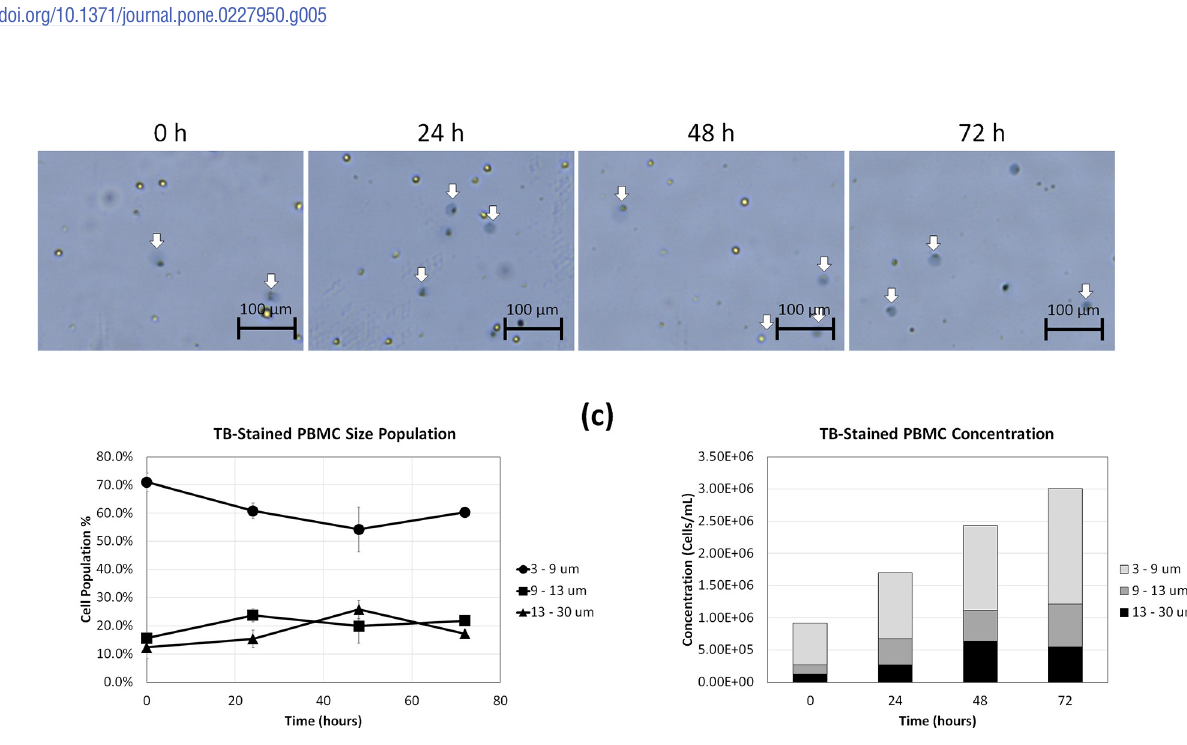
Fig 6. Time-course morphological analysis of TB-stained PBMCs. (a) Bright field images of TB-stained PBMCs acquired by the AutoT4 showing diffuse objects. (b) Time-dependent size populations over 72 h, showing increase in diffuse objects. (c) Concentration changes for different size populations over